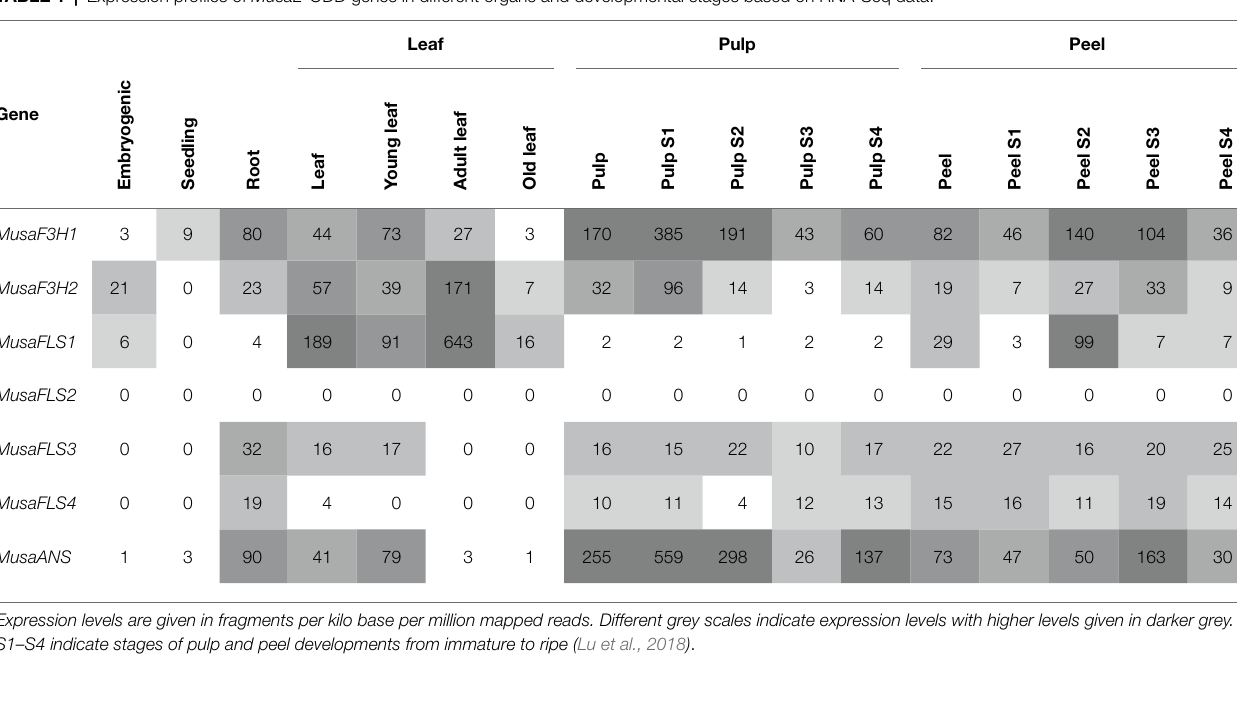
TABLE 1 | Expression profiles of Musa2- ODD genes in different organs and developmental stages based on RNA-Seq data.